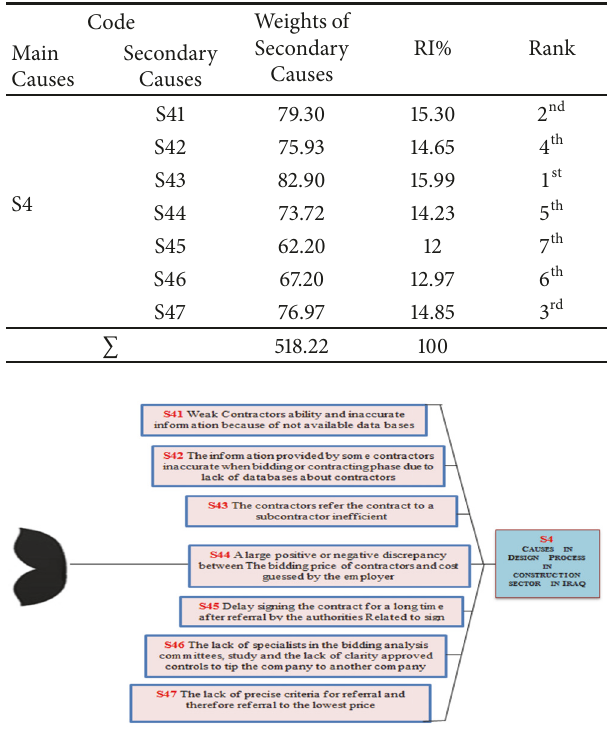
Figure 9: Fishbone diagram for project contract management process group.